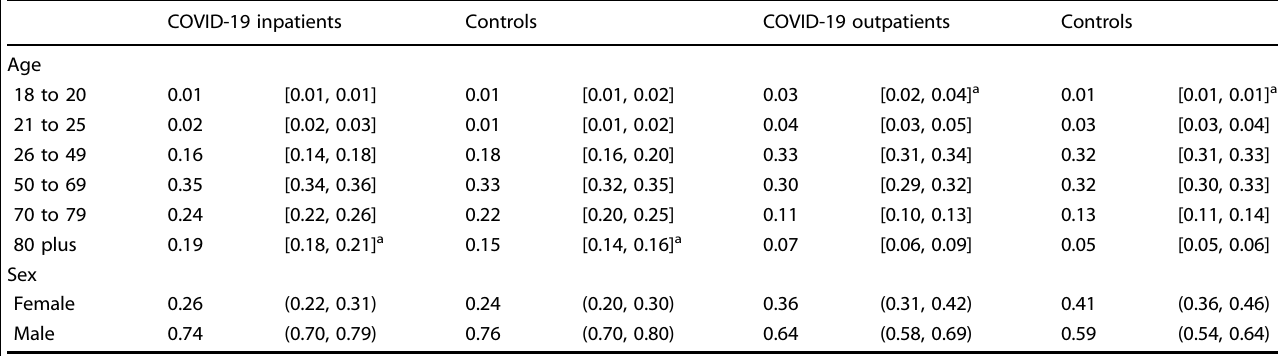
Table 1. Proportion of subgroups (95% con fi dence intervals) of age and sex among inpatient and outpatient COVID-19 cases and corresponding control